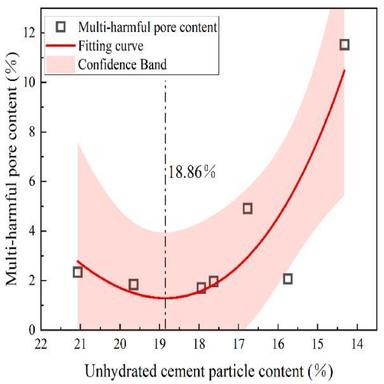
Relationship between the content of unhydrated cement granules.